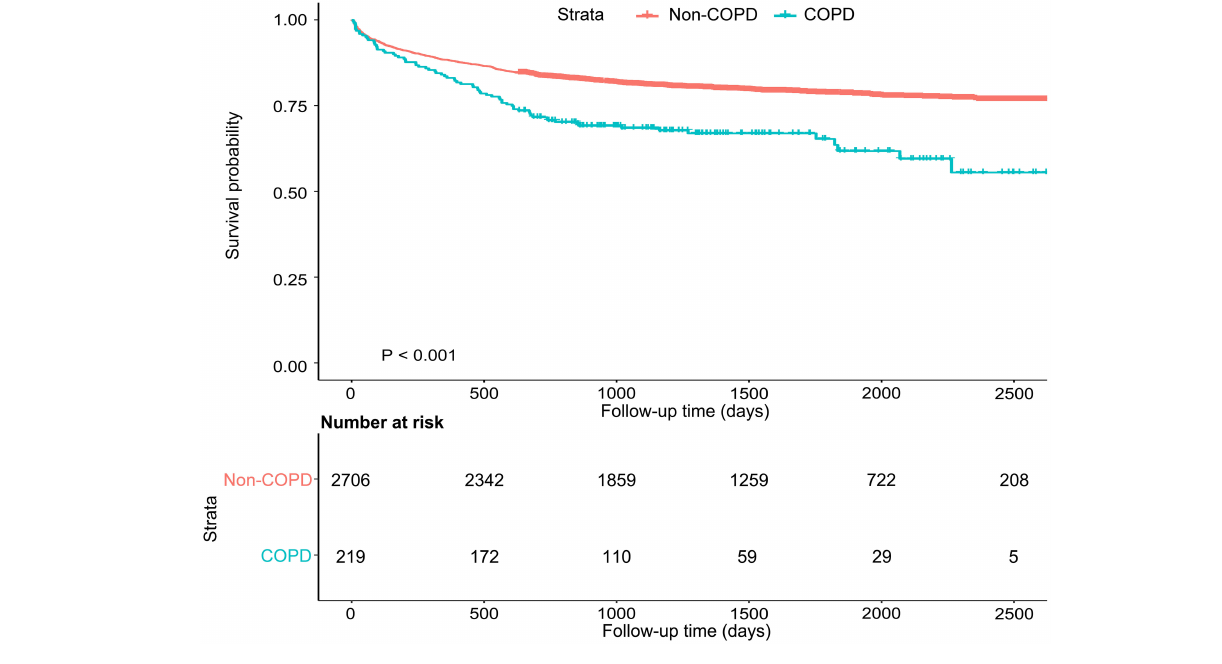
susceptibility to brain injury. The intraneural hypoxemia can occur in ∼ 40–50% of patients with mild COPD (21). Third, COPD have associated comorbid conditions after stroke, such